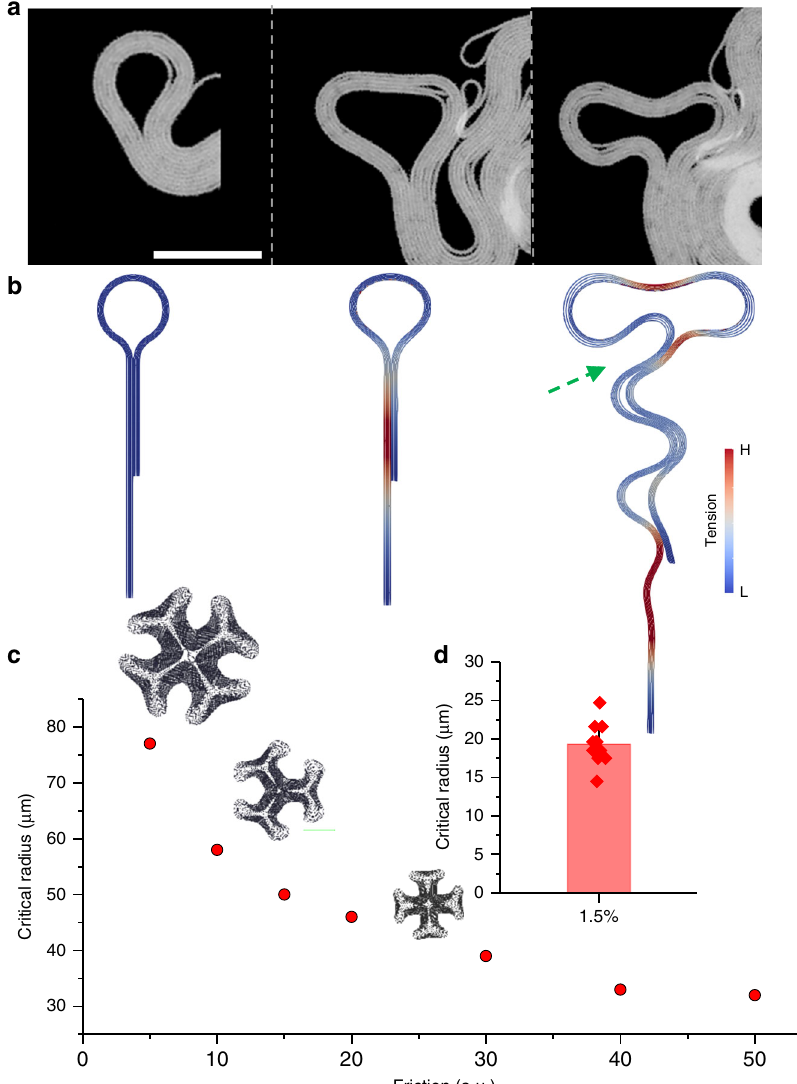
Fig. 3 Edge instabilities of a growing bio fi lm. a Snapshots of growing multilayered circles. The radius reaches the critical radius and splits into two. Scale bar, 30 μ m. b Snapshots from the simulation of a droplet-like structure with a long tail. Color code shows the stress level. While the droplet splits into two circles, the long tail locally buckles, since its length is above the critical buckling length. The green arrow shows the secondary buckling region which asymmetrically folds the circular structure onto the colony edge. c Multilayered growing circles are simulated under various friction forces. The plot of critical radius against friction, simulation results. Units are arbitrary. All snapshots were taken as the secondary edge instability occurred. d Experimental data of the critical radius. The colonies were grown on 1.5% agarose concentration. Error bar is de fi ned as